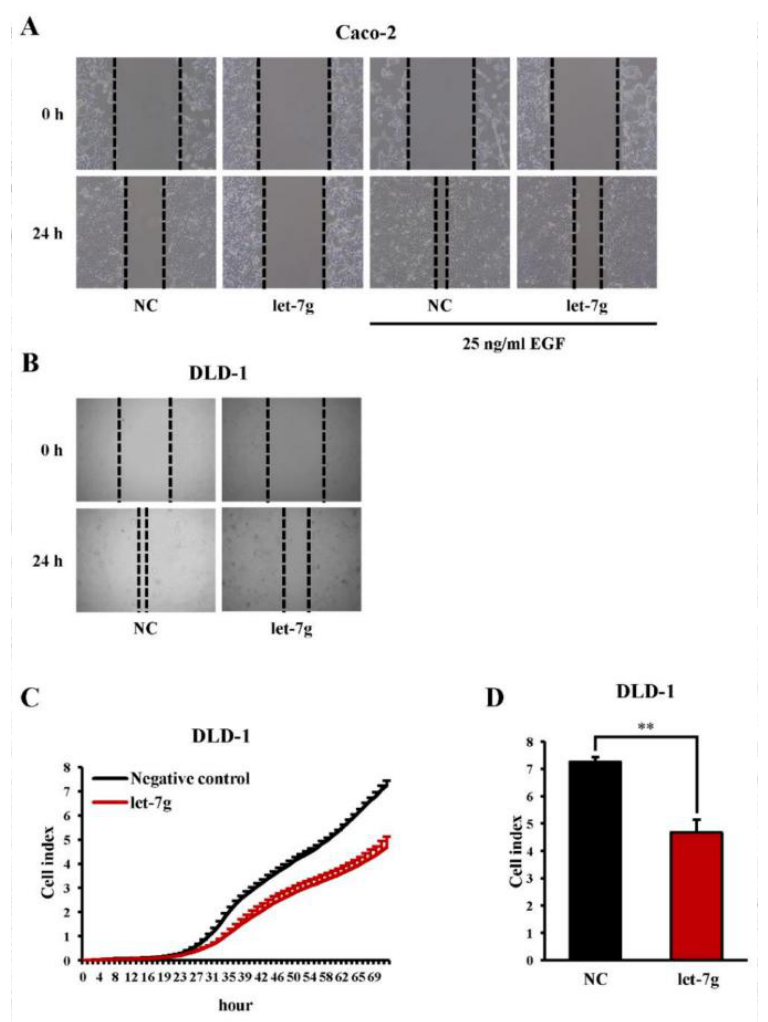
Figure 3. Effect of let-7g on cell migration in colorectal cancer cells. ( A , B ) A cell-free gap was generated by seeding a miRNA negative control and let-7g -transfected cells inside a culture insert to perform a wound-healing assay. The cell migration of Caco-2 (magnification, × 10) and DLD-1 (magnification, × 20) cells with and without epidermal growth factor (EGF) treatment was assessed by imaging at 0- and 24-h time points. ( C ) The real-time cell migration of the miRNA negative control and let-7g -transfected DLD-1 cells was analyzed by an x’Celligence Biosensor System. (D) The real-time DLD-1 cell migration after 72 h was quantified. **, statistically significant at a p -value of